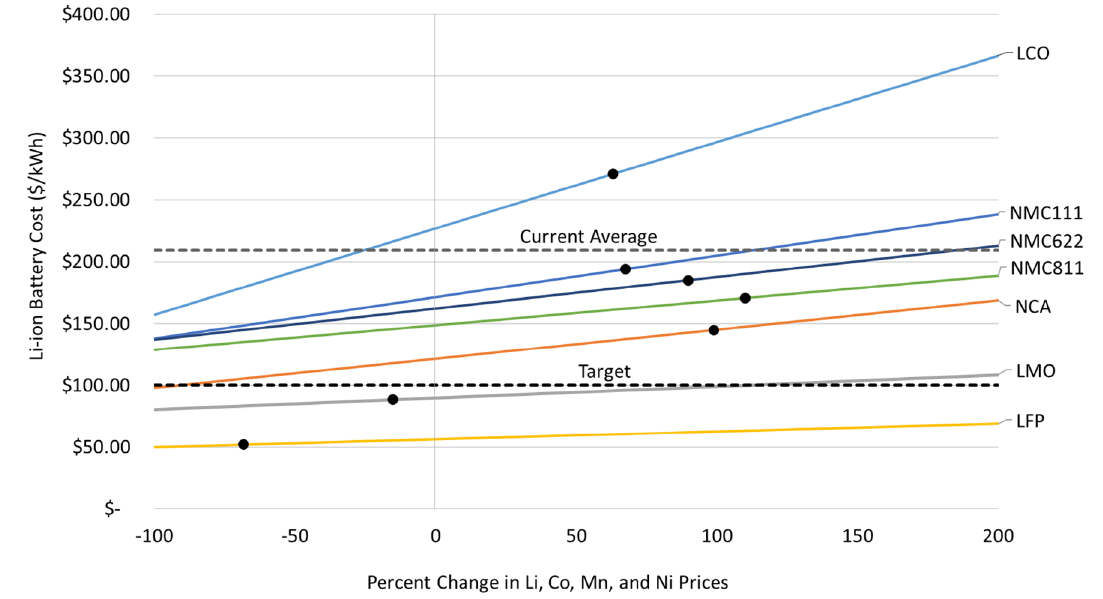
tery costs that would have occurred if the current material intensity scenarios experienced the material prices of 2008. Sources [52, 69, 70, 82, 83]